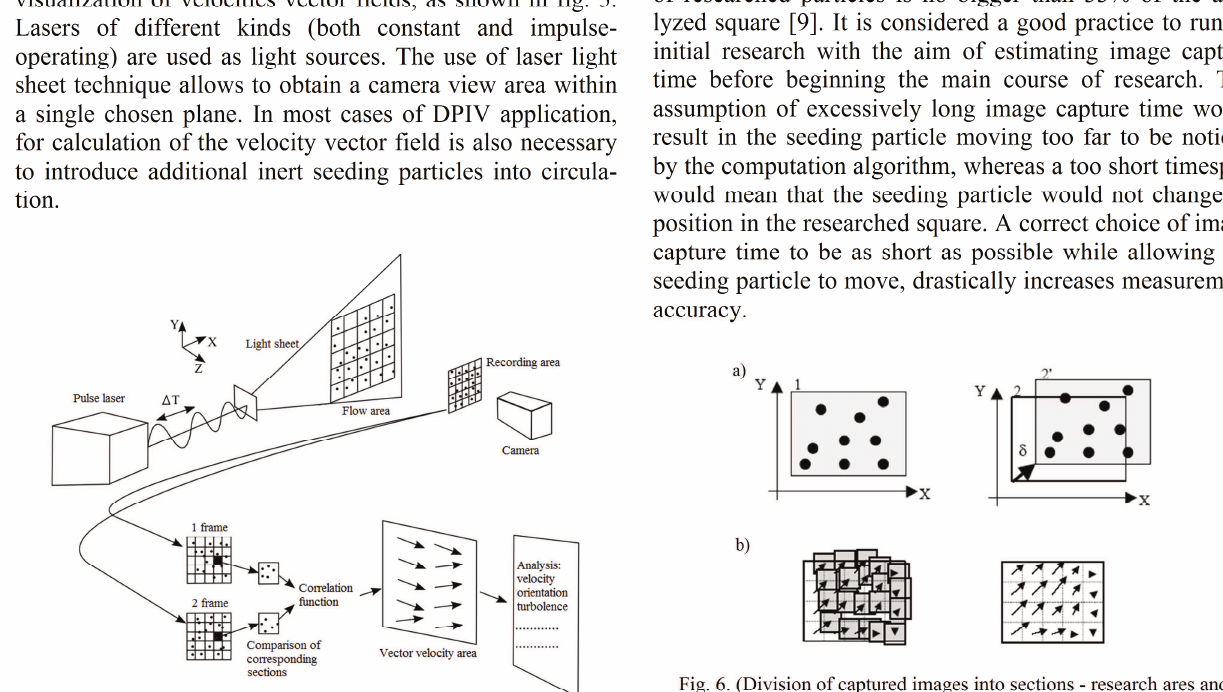
Fig. 6. (Division of captured images into sections - research ares and designation of movement vectors for each section. 1-image section 1, 2- image section 2, 2’image sections 1 found in section 2 δ -translation of section 2’ in relations to section 1, conversion of translations to velocity vector field)